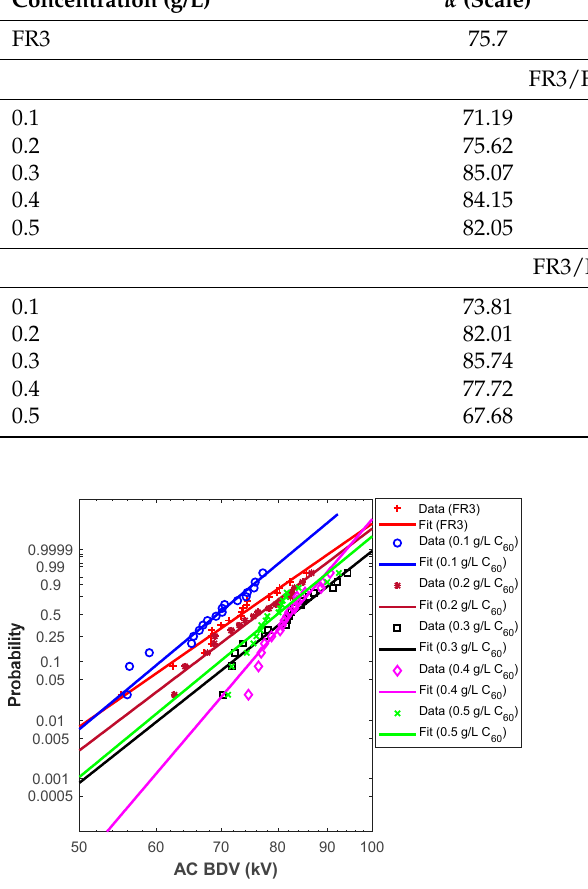
Figure 3. Fullerene NFs Weibull probability plots.